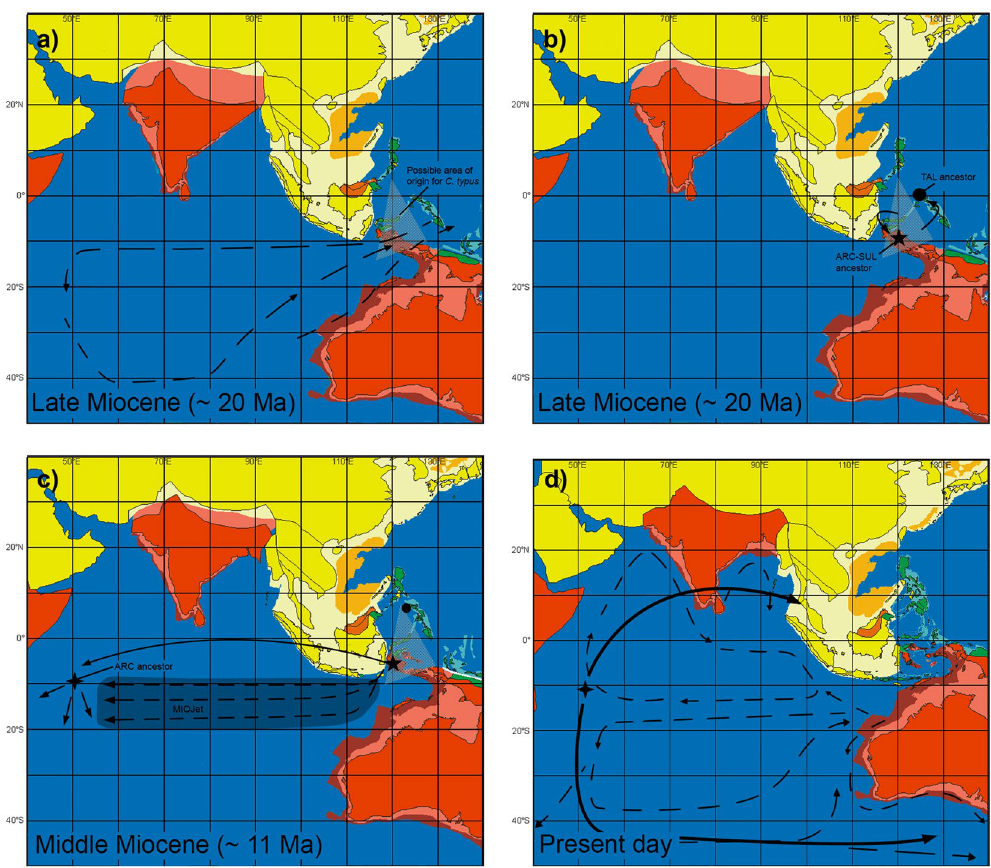
Figure 5. An illustrated suggestion for the biogeographic history of C . typus . In ( a ), the grey dashed triangle represents the possible ancestral location for the population that would originate based on TAL’s ancestral range inference. The ancestral population would have spread to other locations in the precursor IAA ( b ) probably westwards, to Taliabu, the precursor islands of Sulawesi and/or, based on ARC’s ancestral range inference, the Philippines. With the establishment of the MIOJet, individuals from this ARC-SUL ancestor would have spread to the Indian Ocean and initiated the population that would originate ARC ( c ). The closure of the MIOJet would finally establish currents as they are today and permit the colonisation of Langkawi and the Pacific by ARC. The dashed arrows represent surface currents based on Gourlan et al . (2007) and bold arrows represent postulated dispersal events. The dots represent possible points of establishment and isolation of TAL; the star indicates possible points of origin of the ARC-SUL clade; the compass rose indicates the most probable point of origin for the ARC clade. Coastal shelf areas are marked in a lighter tone than the continental areas. Paleomaps were modified from Hall